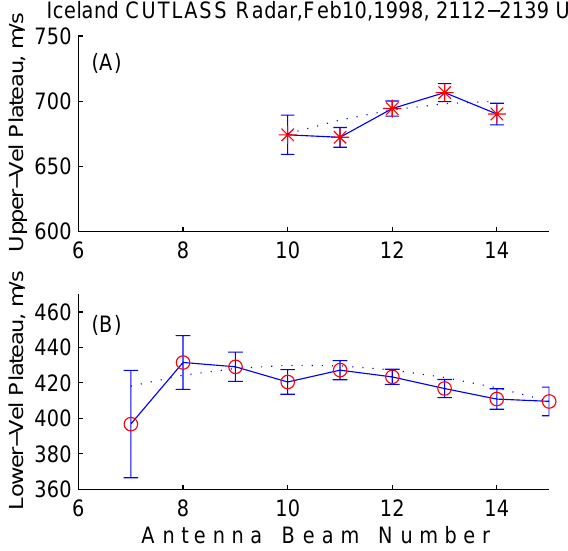
Fig. 5. Average echo velocity in various beams of the Pykkvibaer HF radar on 10 February 1998, (a) for the high-velocity plateau data and (b) for the low-velocity plateau data. The dotted lines are cosine variations with the velocity maxima positioned at some